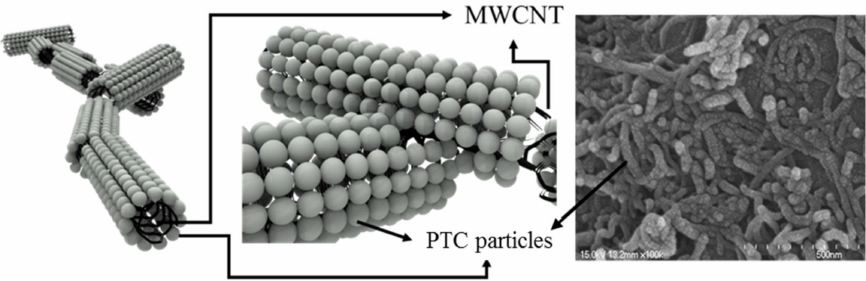
Figure 6. SEM images of the PTC-SHE screen-printed twice with 0.25 wt% multiwall carbon nanotube (MWCNT) ink, and illustrations of the PTC-MWCNT particles in the ink comprising PTC particles attached to the outer walls of the MWCNTs.